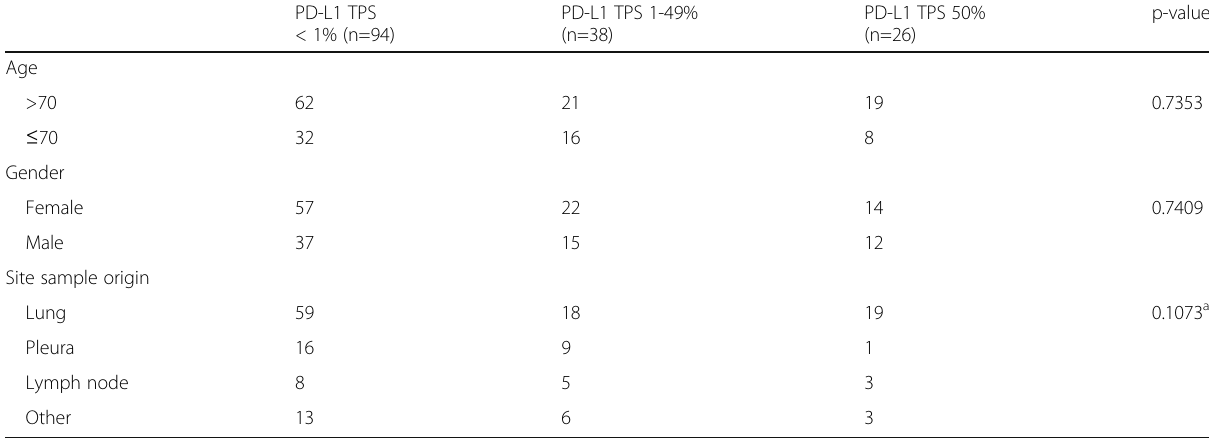
PD-L1 programmed cell death – ligand 1, TPS tumor proportion score a Lung versus